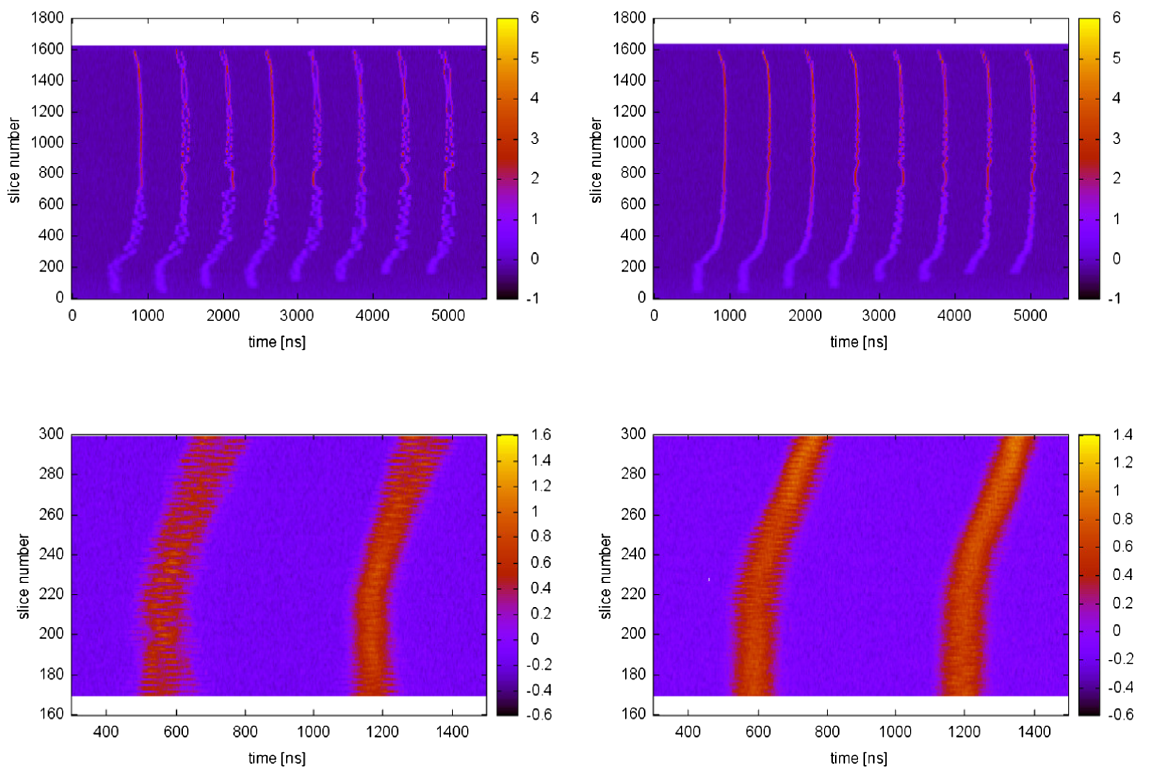
FIG. 13. Mountain plots of the WCM signals from injection to extraction (left) without and (right) with feedforward. Bottom plots are magnified ones of the K1 injected bunches around the smoothing Fig. 12. One can notice that no growth of the oscillation during the smoothing period is observed in the lower right plot. The average momentum deviation becomes much smaller as shown in the lower plot of Fig. 14. Therefore, the beam losses in the arc sections disappear with feedfor- ward, as shown in Fig. 15.